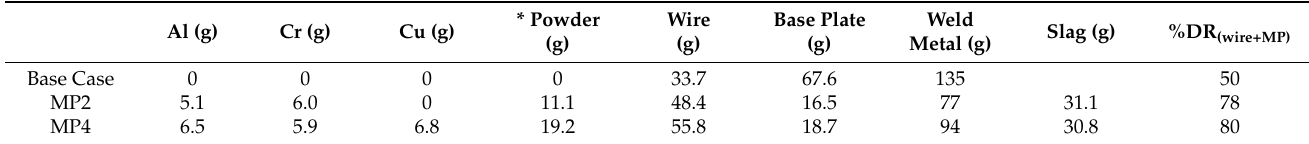
Table 6. Post weld masses and metal powder mass added to weld metal.